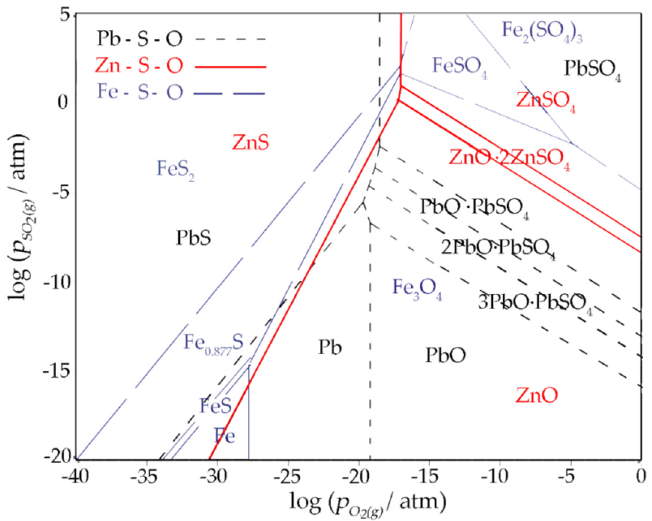
Figure 12. Equilibrium amounts of the sulphide ( a , b ) and oxide products ( c , d ) of sulfidization jarosite-PbAg sludge as functions of carbon and sulfur dosage, and temperature 550 °C ( a , c ) and 900 °C ( b , d ).